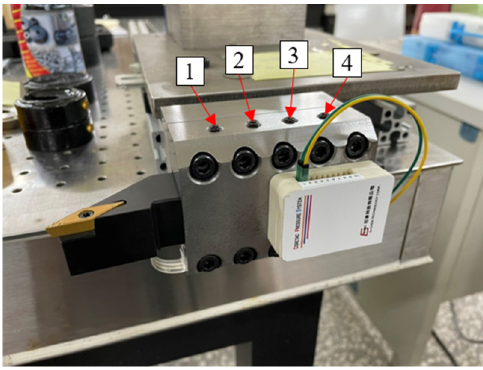
Figure 8. The completed smart tool holder that is clamping a turning tool. The smart tool holder includes the tool holder structure, the film force sensor, and the wireless data acquisition unit.